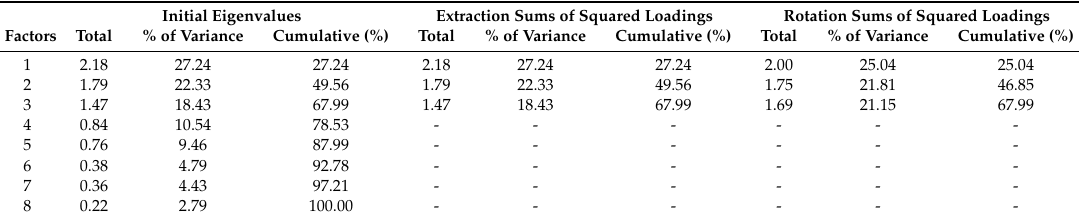
Table 4. Total variance analysis and factors loading.